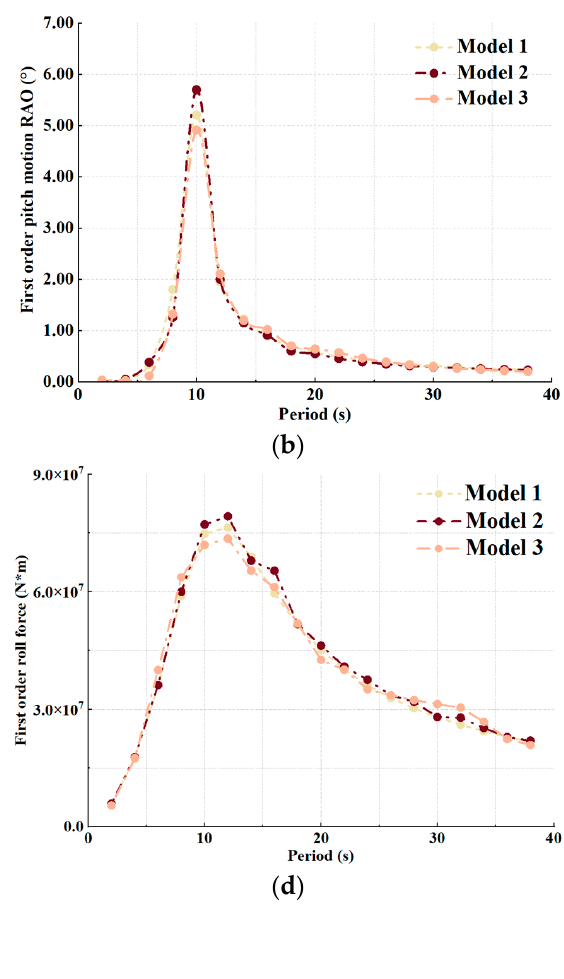
Figure 4. Mesh model. ( a ) Model 1 (0.75 m × 0.75 m); ( b ) Model 2 (1.00 m × 1.00 m); ( c ) Model 3 (1.25 m × 1.25 m).